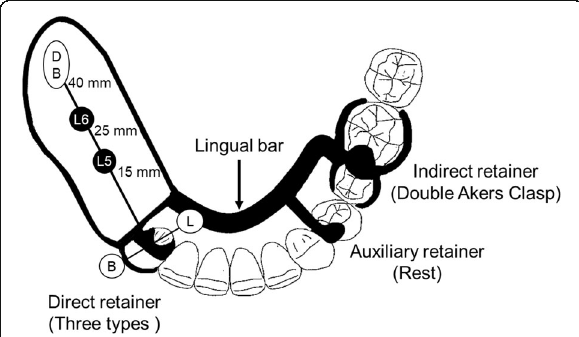
Fig. 2 Schematic illustration of a mandibular experimental distal- extension removable partial